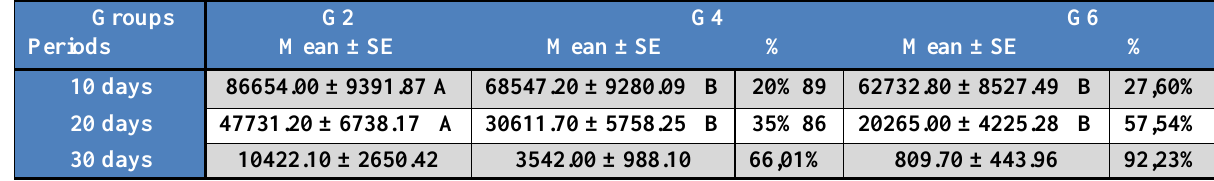
Different capital denote significant (P<0.05) differences among groups. Different small letters denote significant (P<0.05) within groups as pretreated period. Reduction (%) = opg before treatment – opg after treatment ×